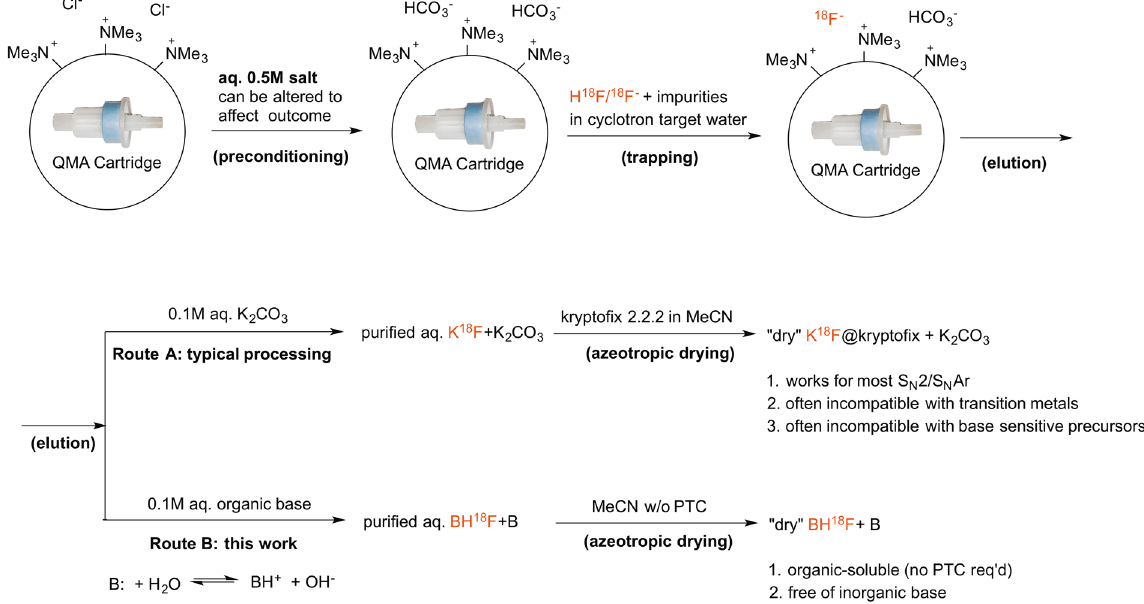
Figure 1. Typical fluorine-18 processing using ( A ) conventional approach and ( B ) the new approach described in this manuscript (B =